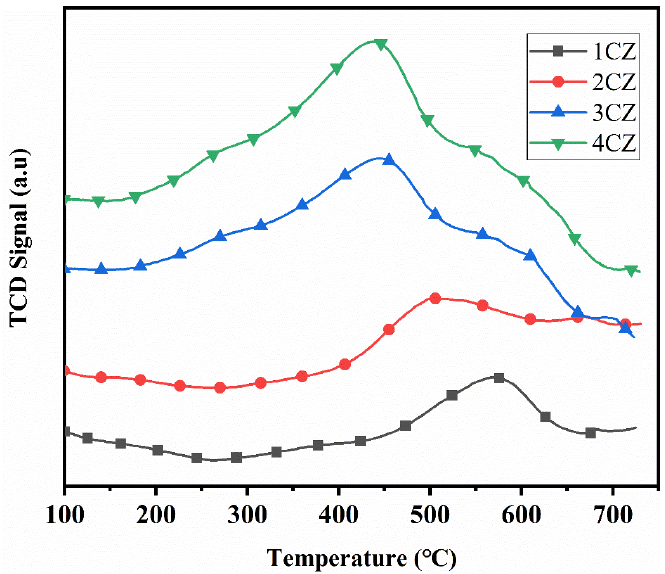
Figure 11. H 2 -TPR profiles for the CZ